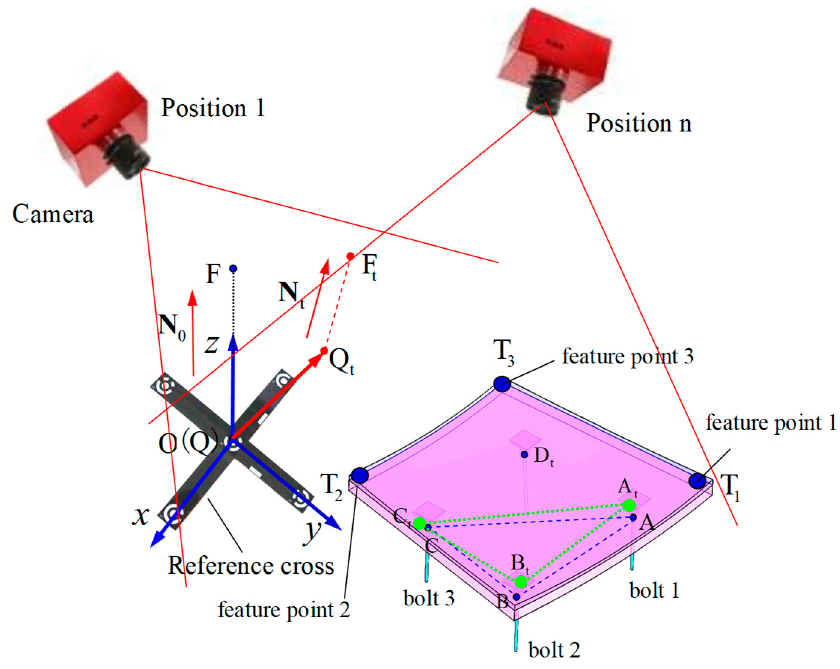
Figure 1. ( a ) Photograph of the 38 kW dish ‐ Stirling solar thermal power system (38 kW XEM ‐ Dish System), ( b ) Image of the posterior side of the mirror unit, ( c ) image of the support ‐ adjust structure on the back of the mirror unit, and ( d ) schematic of the assembly model of the support ‐ adjust structure.